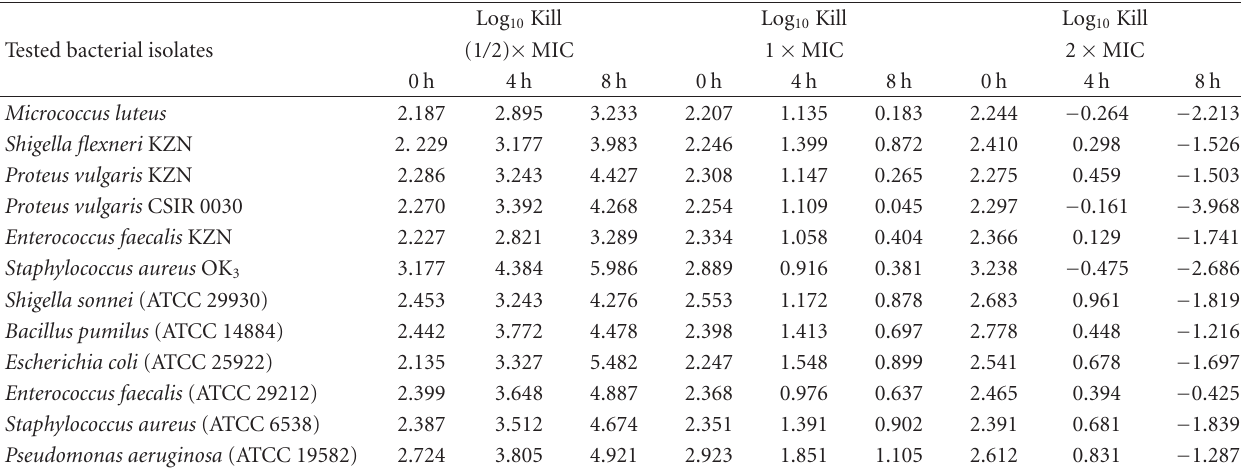
Table 3: In vitro time-kill assessment of the crude ethanolic stem bark extract of E. ca ff ra . Log 10 Kill Log 10 Kill Log 10 Kill Tested bacterial isolates (1 / 2) ×